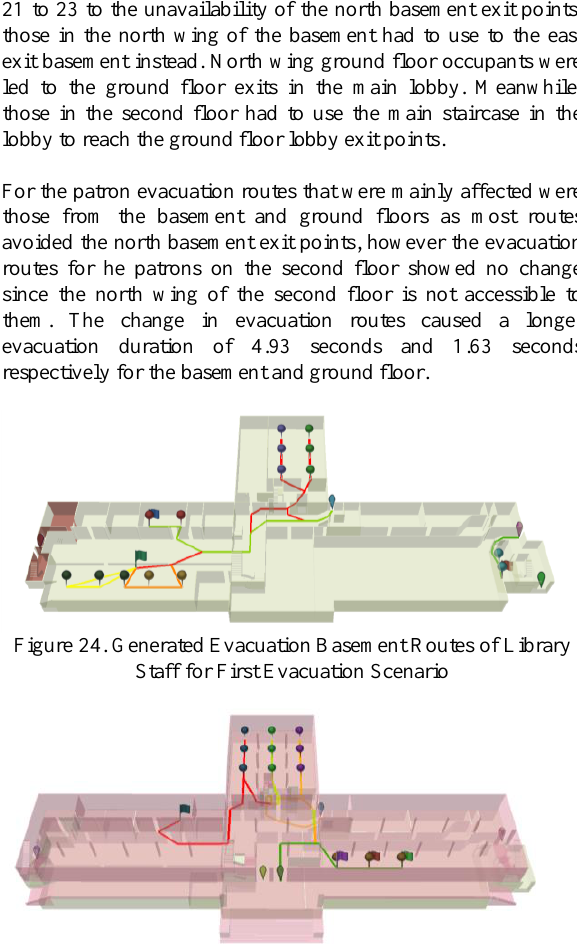
Figure 25. Generated Evacuation Ground Floor Routes of Library Staff for First Evacuation Scenario